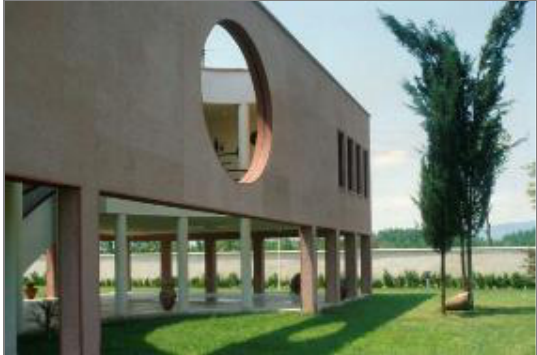
Figure 16 Mehmet Konuralp and Salih Sağlamer, Sagra Residence and Guesthouse, Ordu